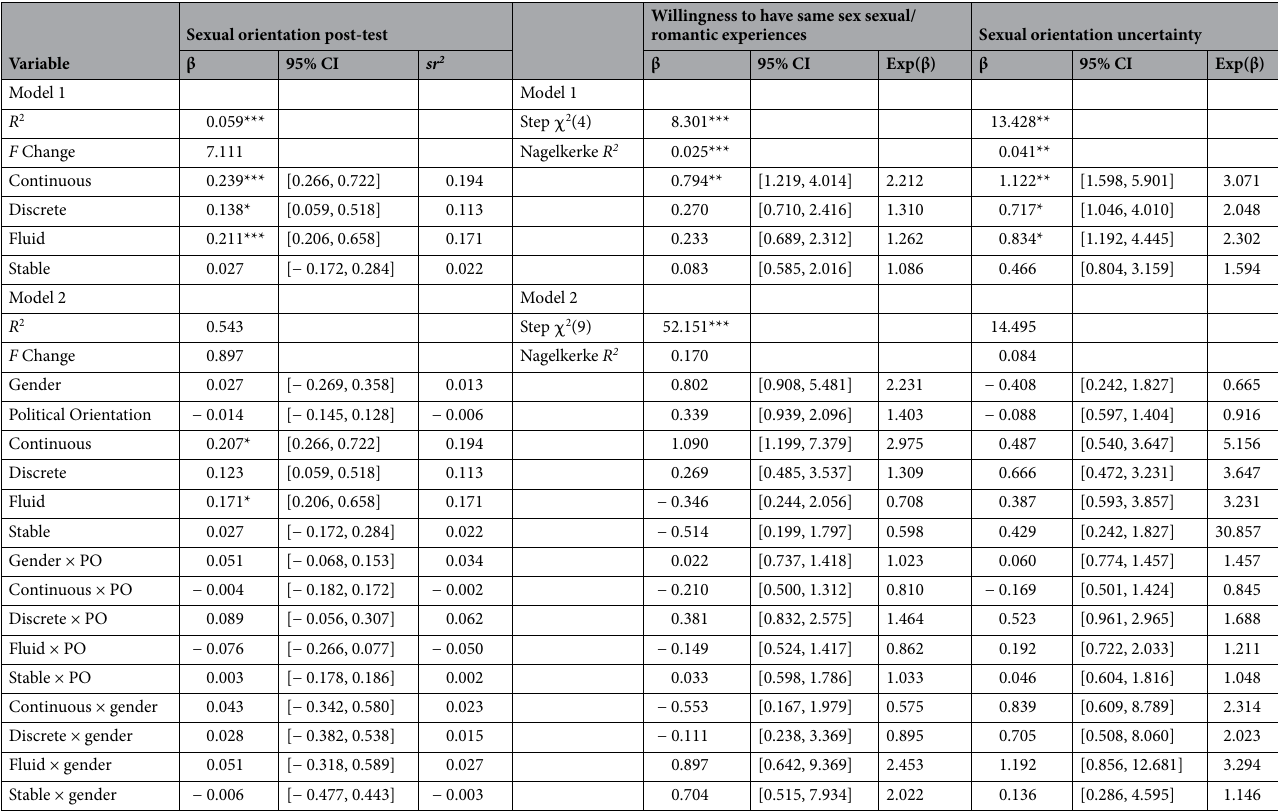
Table 4. Study 2. Effects of reading continuous, discrete, fluid, and stable accounts on sexual orientation self- ratings and secondary indices. PO political orientation * p < 0.05; ** p < 0.01; *** p < 0.001.